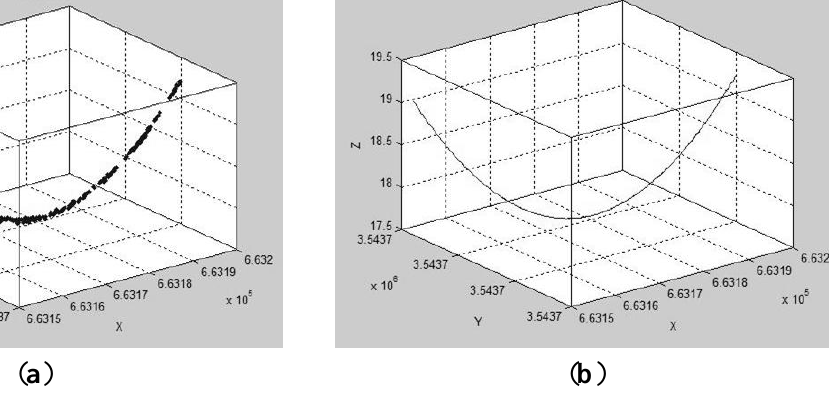
Figure 8. Three-dimensional power line fitting. ( a ) Power line points. ( b ) Fitted